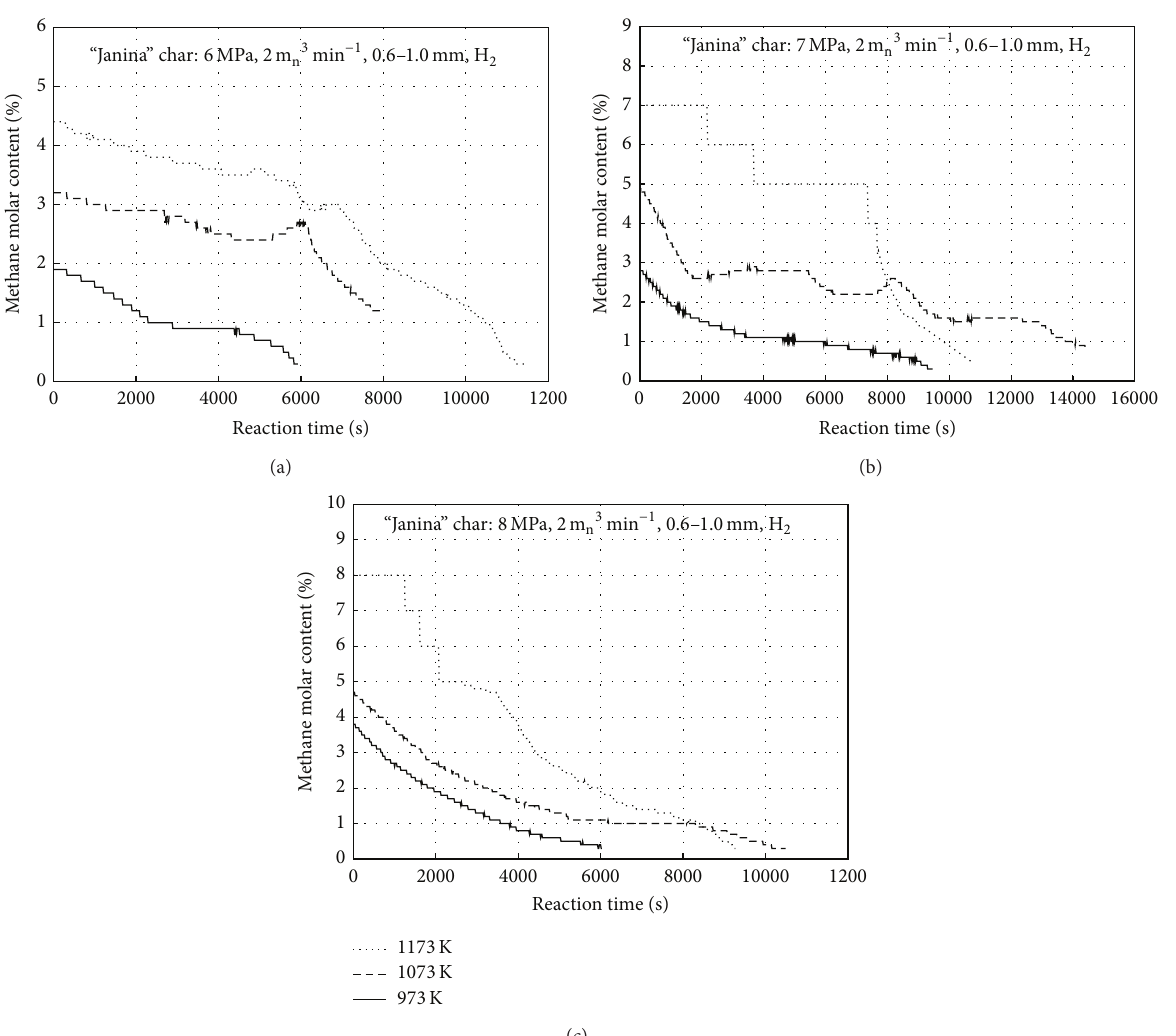
Figure 3: Measured molar content of the outflow gas methane versus time for “Janina” char at 1173, 1073, and 973 K for (a) 6MPa, (b) 7 MPa, and (c)